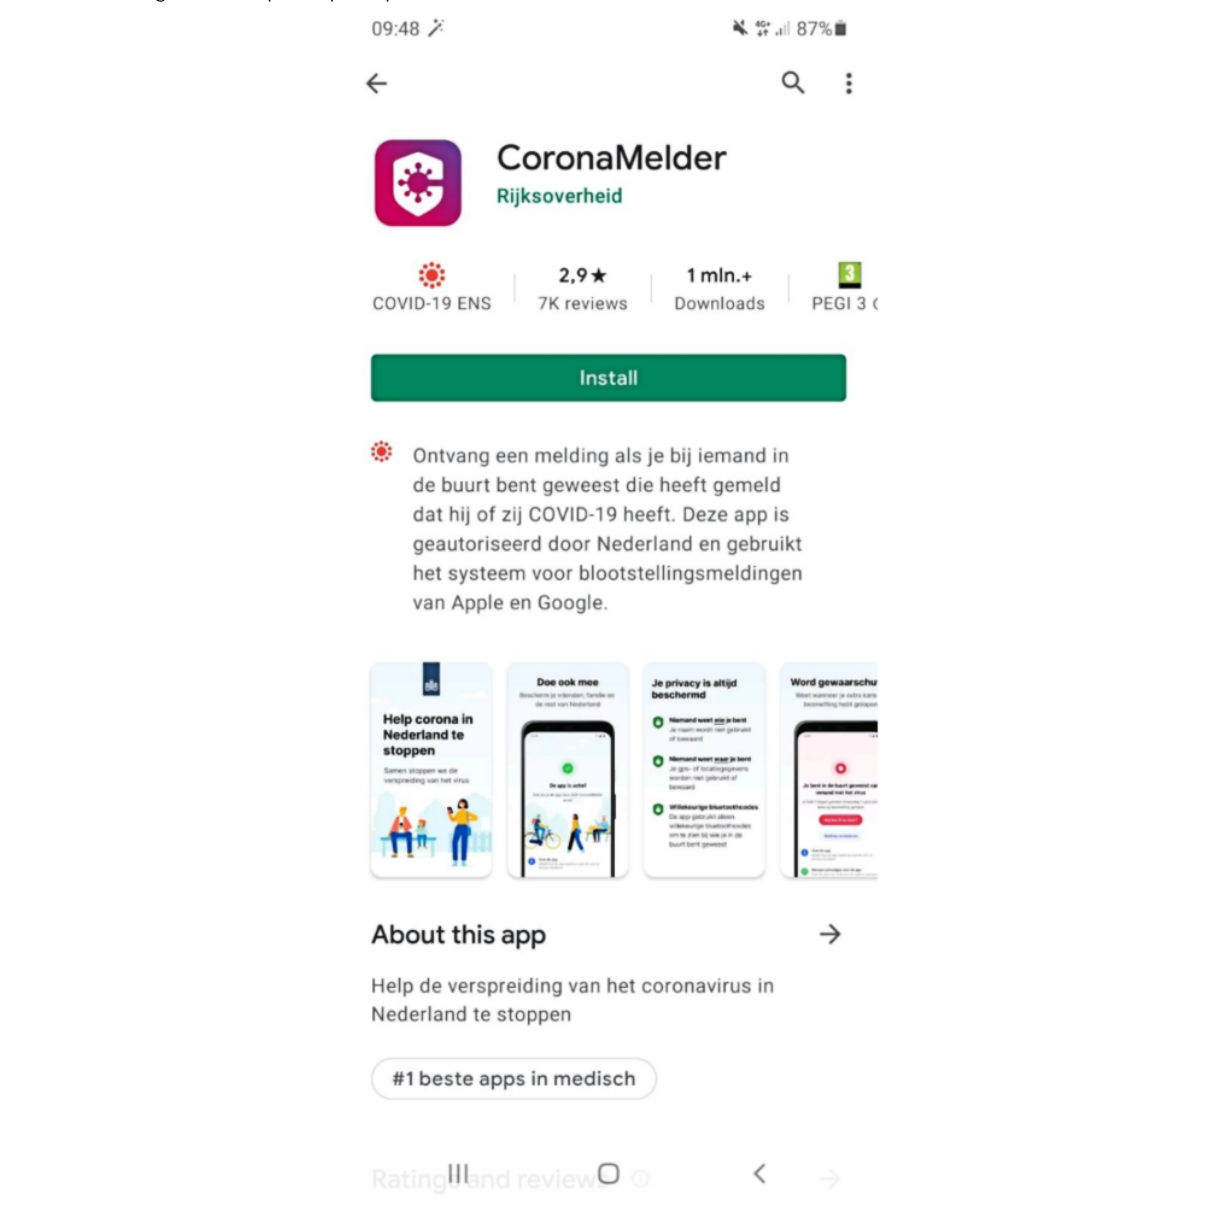
Figure 4. The CoronaMelder app as seen in the Google Play Store. The app can be installed by clicking the Install button. The text below this